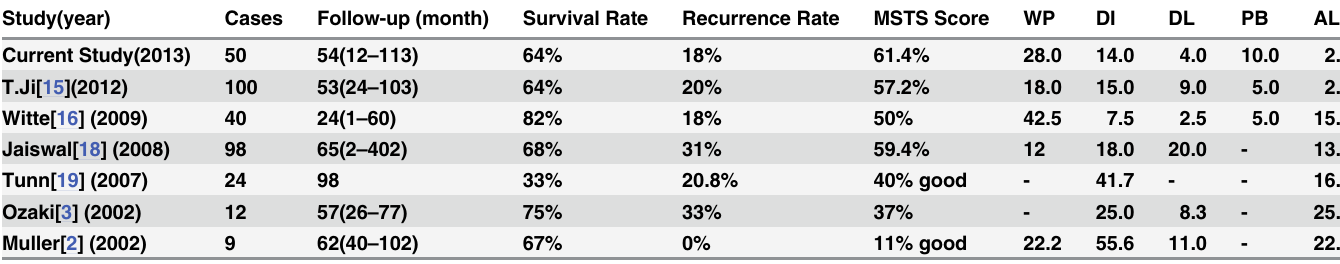
Table 3. Results of oncology and functional status, and complication